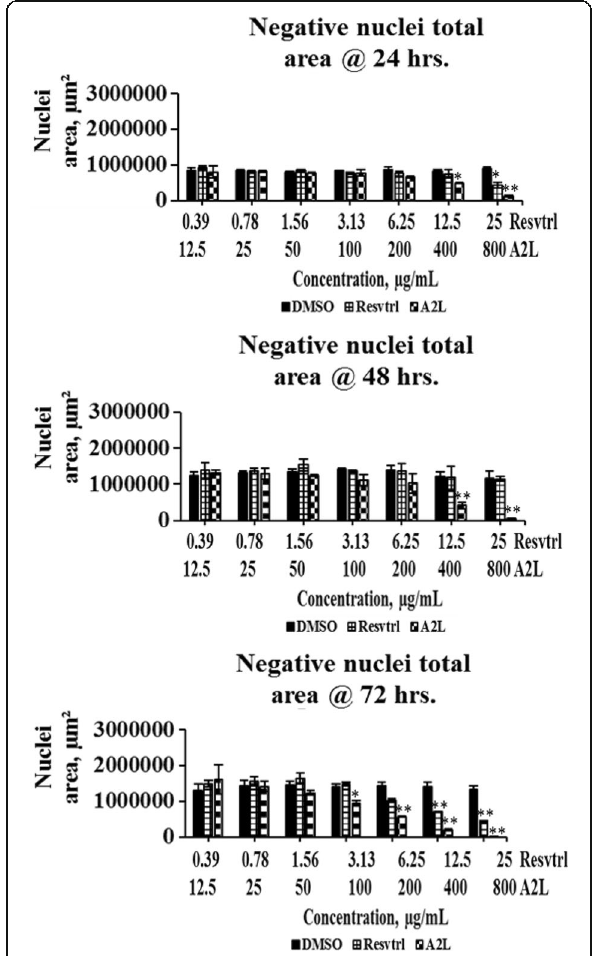
Fig. 4 Determination of negative nuclei total area. Changes in negative nuclear size associated with treatment of HepG2 cells with resveratrol or A2L followed up for three days. * p < 0.05; ** p <